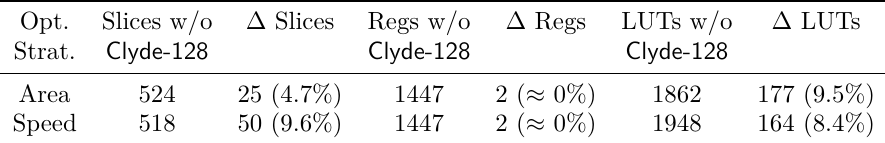
Table 10: Practical cost of Clyde-128 on top of Shadow-512 ( N u = 8). Opt. Slices w/o ∆ Slices Regs w/o ∆ Regs LUTs w/o ∆ LUTs Strat.